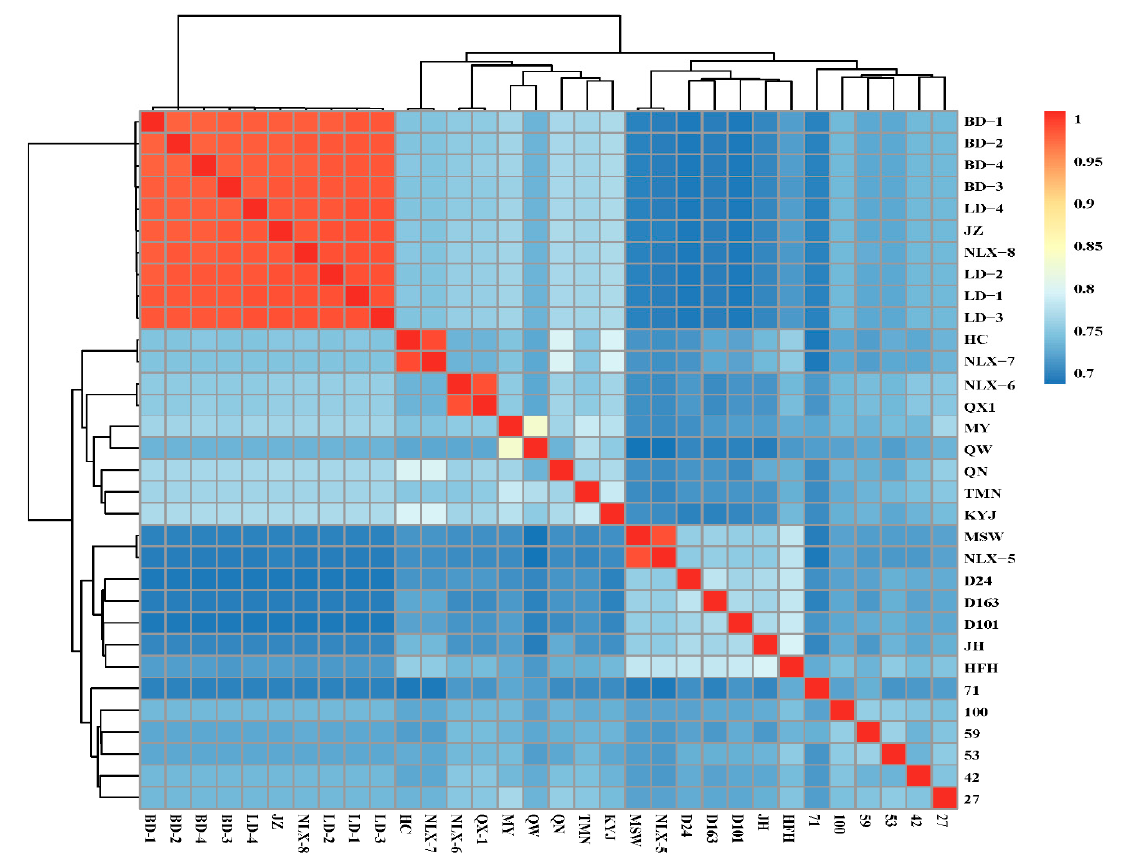
Figure 1. Heatmap of identity by state (IBS) distance matrix of the conserved population of 32 durian genotypes. Each small square in the IBS distance matrix represents the genetic distance value between two pairs from the first sample to the last sample. The larger the value, the closer to red, thus the larger the genetic distance between two individuals, and vice versa.